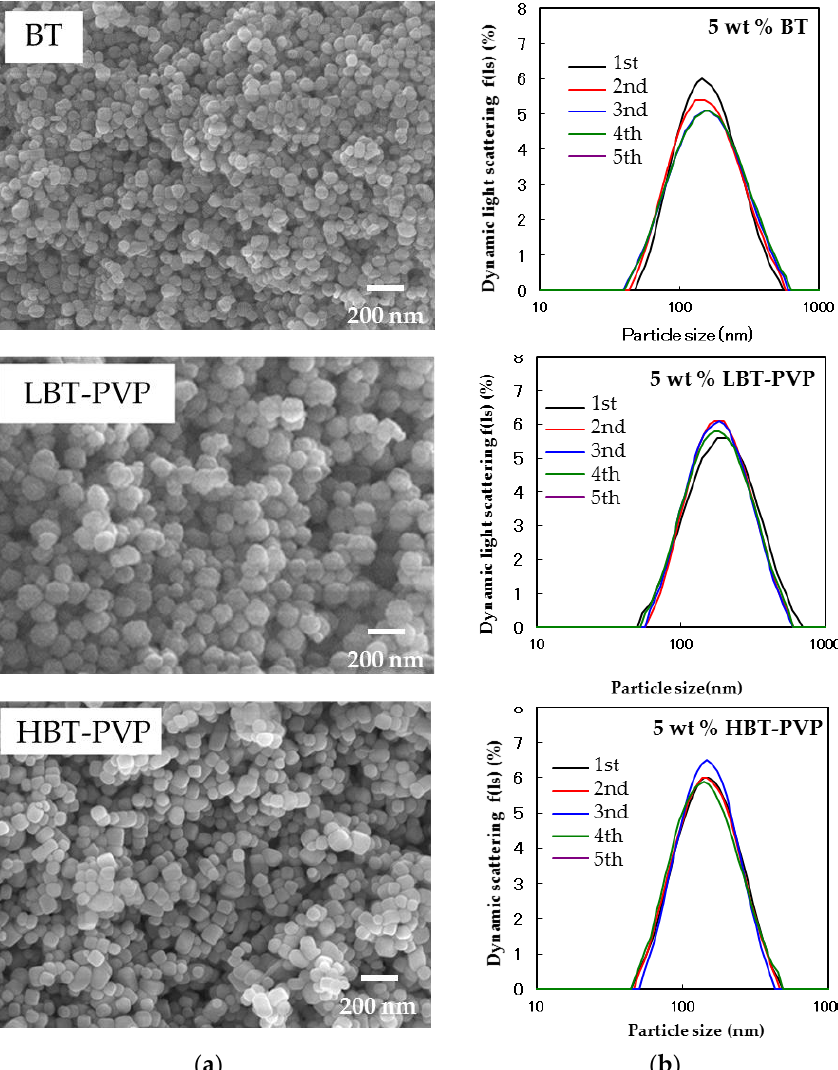
Figure 1. FE-SEM images ( a ) and dynamic light scattering (DLS) ( b ) of 5 wt % BT, LBT-PVP, and HBT-PVP in EtOH solution. The measurement of DLS is sequenced five times.